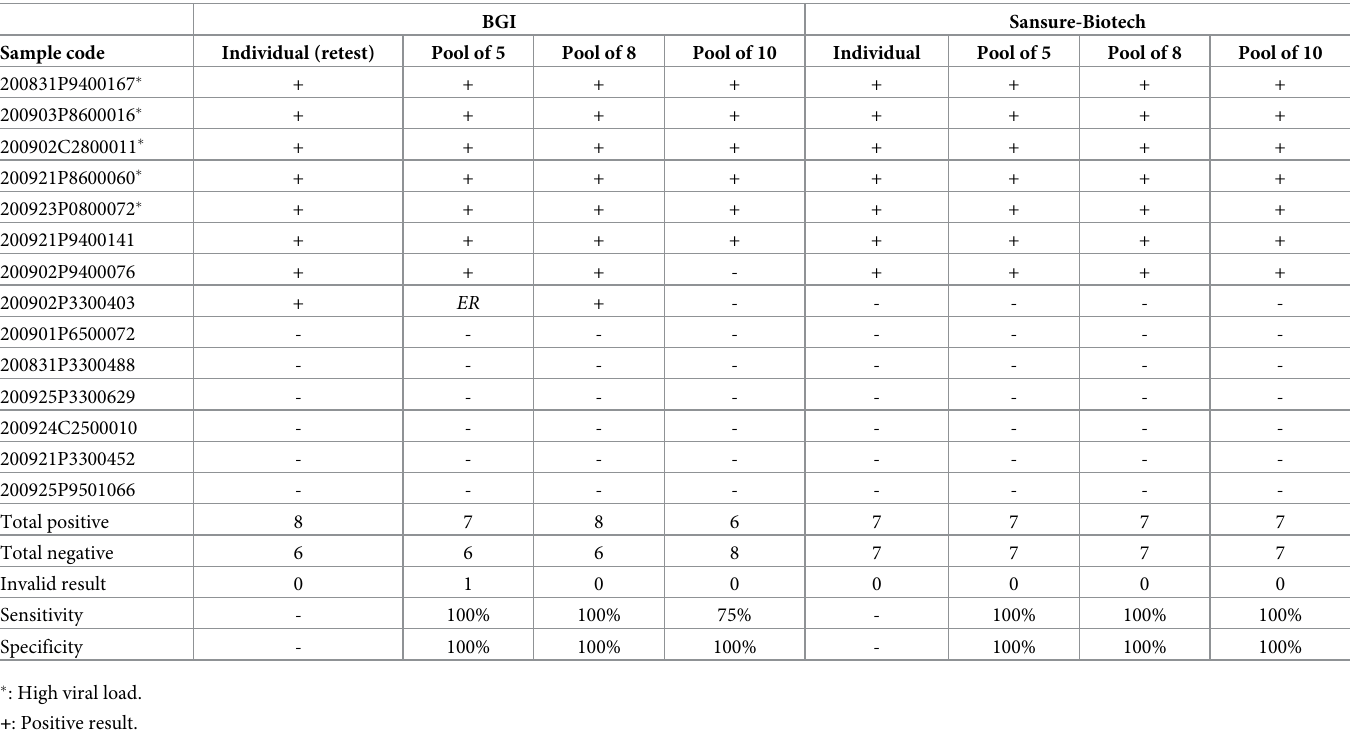
Table 2. Results of the individual (retest) and experimental pooling method. Sensitivity and specificity of pool test are indicated by considering the individual test as gold standard.